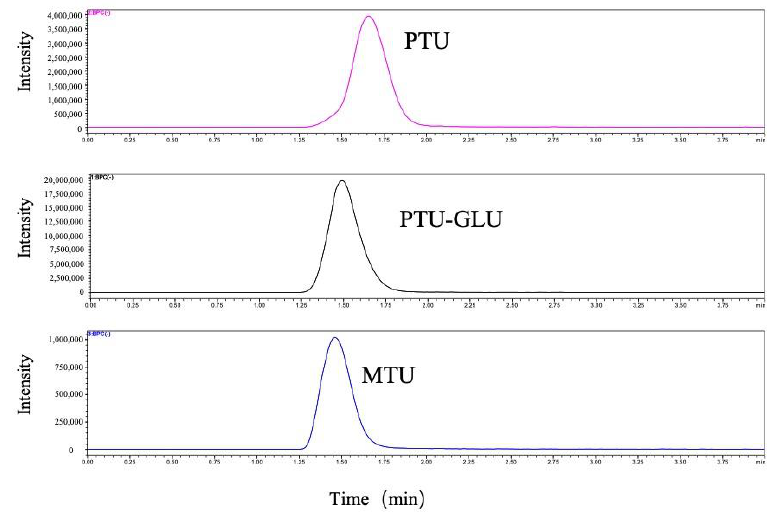
Figure 2. Representative MRM ion chromatograms of PTU, PTU-GLU and MTU.